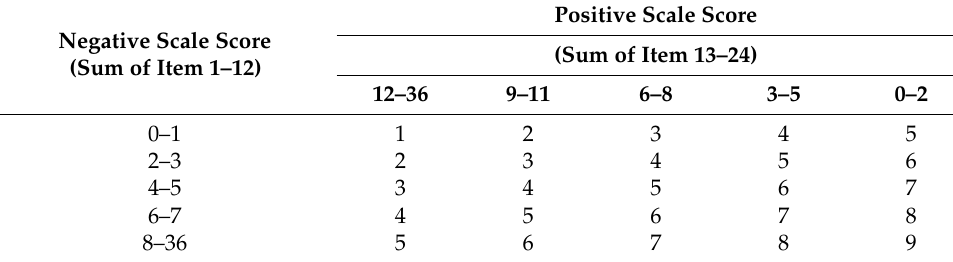
Table 1. Matrix table for the index of TST